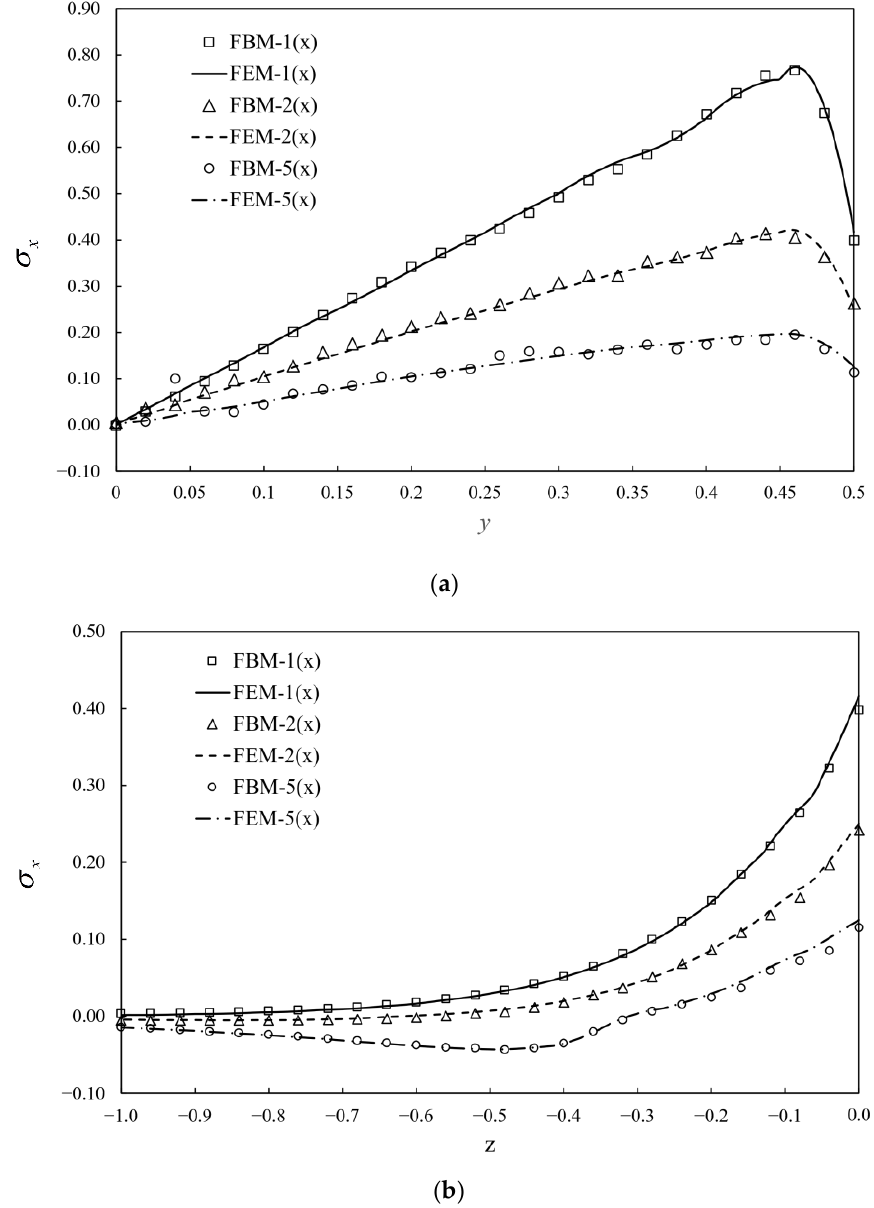
Figure 10. Semi-infinite model with linearly distributed vertical load: ( a ) semi-infinite model with 12 blocks by FBM; ( b ) side view from x-axis.